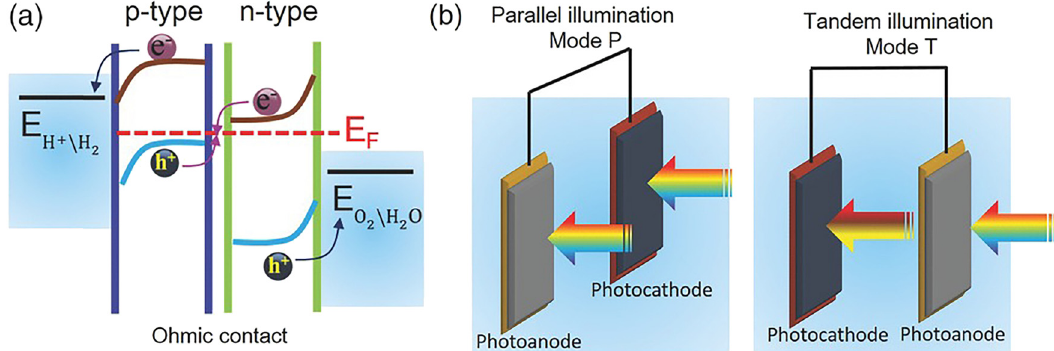
Figure 1: ( a ) Working principle of a PEC cell for overall water splitting based on a photoanode and a photocathode in a tandem con fi guration. ( b ) A schematic of the wired PEC tandem cell under a parallel ( left ) and a tandem ( right ) illumination. Reprinted with permission from ref. [ 20 ] . ©2016 Wiley -